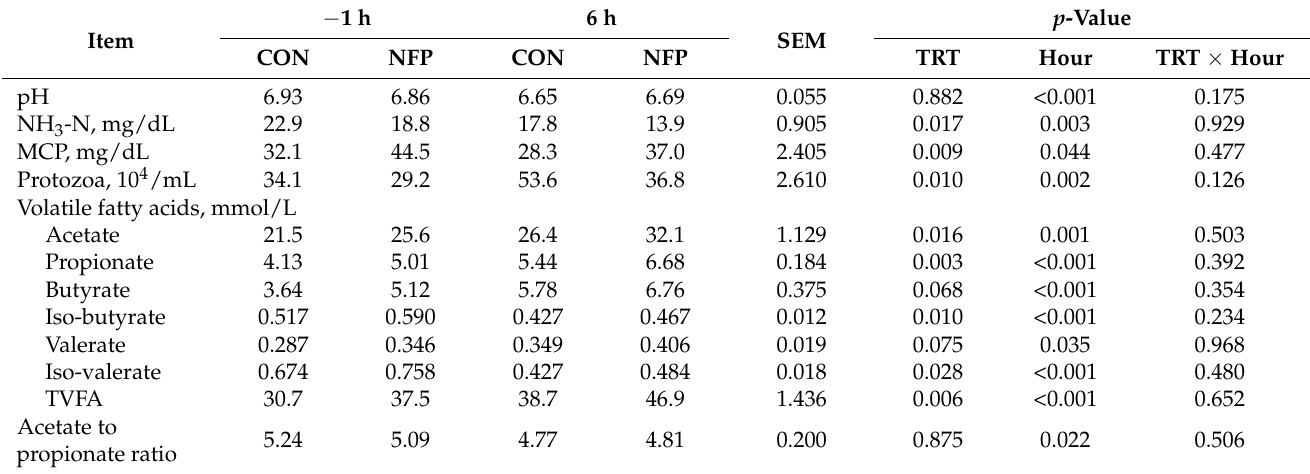
Table 5. The effect of NFP on in vivo variables related to ruminal fermentation in cashmere goats.